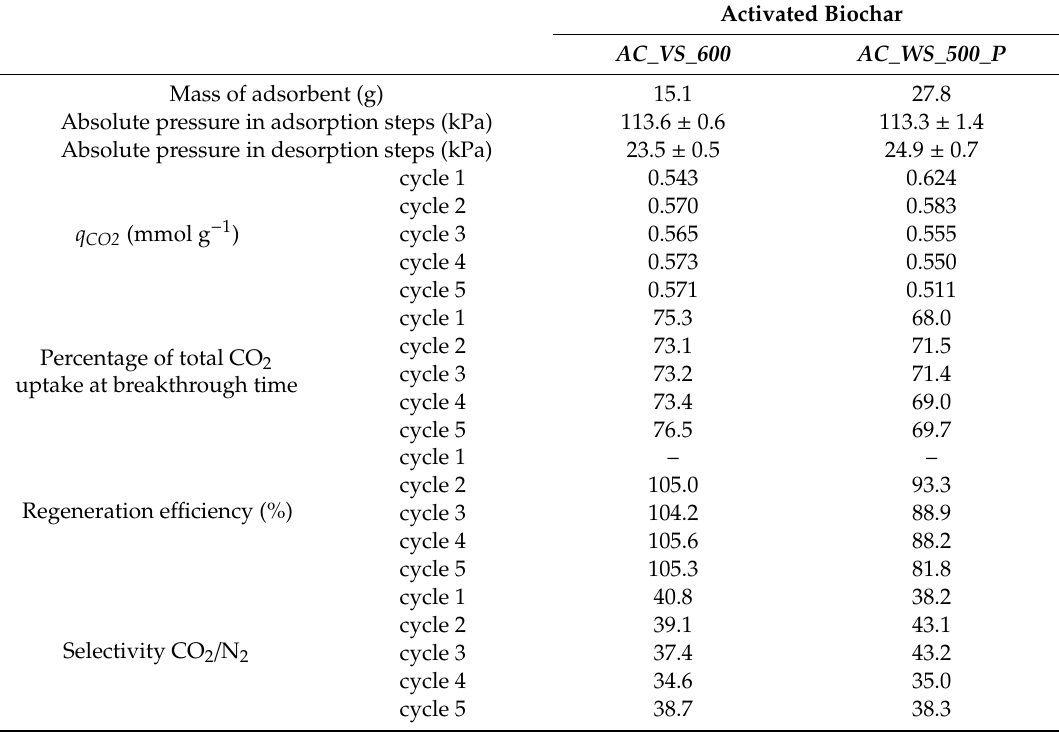
Table 6. Summary of results from the breakthrough experiments (dry conditions) conducted at 50 ◦